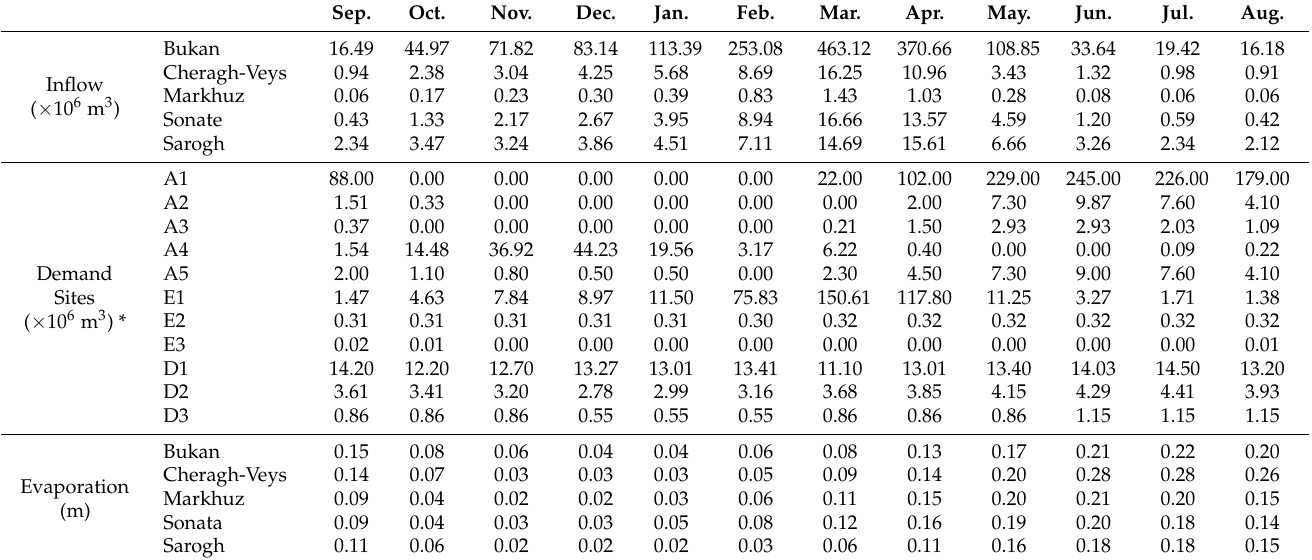
Figure 4. ( a ) Locations of dams within the Zerrineh-rud sub-basin in Kurdistan, Iran. ( b ) Schematic model of the Zerrineh- rud features. Table 3. Monthly average time series used in multi-reservoir